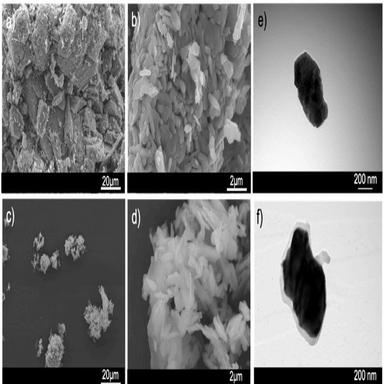
SEM images of (a, b) commercial V2O5 and (c, d) V2O5/PDA-b materials and their corresponding TEM images (e) and (f), respectively.